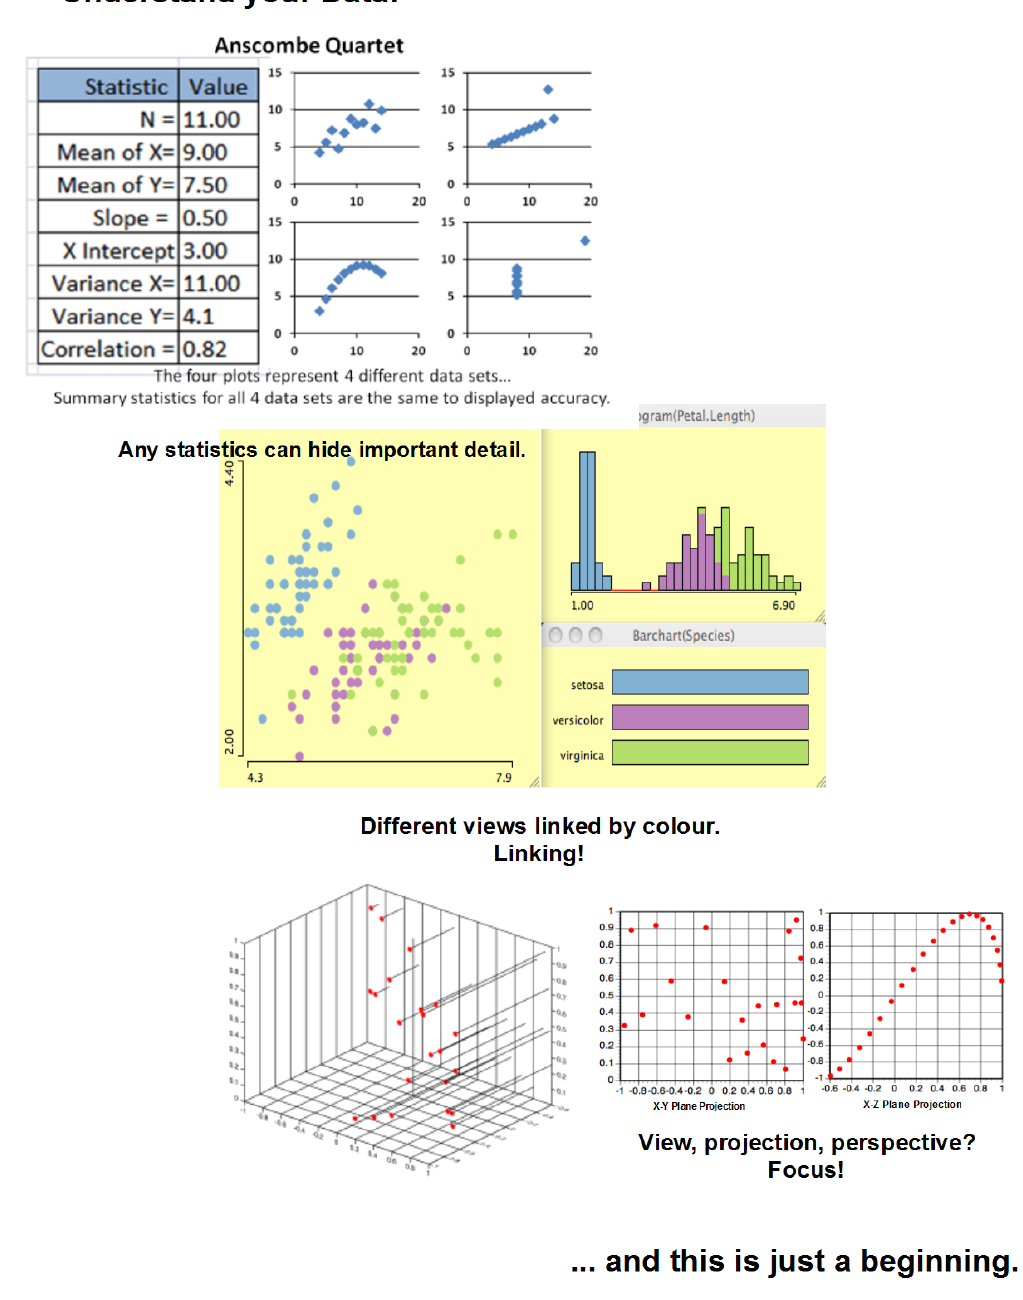
Figure 7. Understand your data.